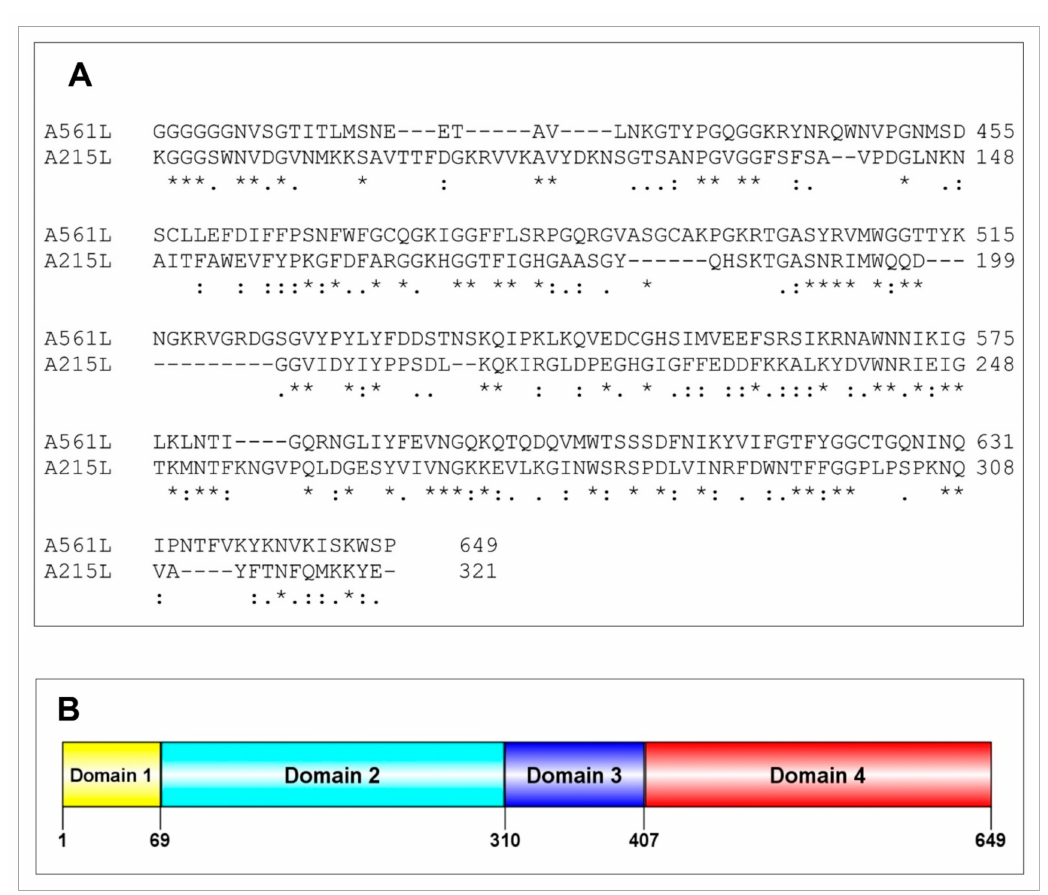
Figure 1. A561L protein characteristics: domains and possible functions: ( A ) Amino acid sequence pairwise alignment of a carboxyl-terminal domain of CDS A561L with the carboxyl terminus of CDS A215L; A215L was previously characterized as a polysaccharide lyase [vAL-1 protein] [38]. ( B ) Predicted domains in A561L—domain 4 is the part of the protein that resembles A215L (domains were identified using InterPro domain prediction database [39] with manual curation). Domain 1 has a transmembrane domain and the closest match is a transporter protein encoded by Listeria kieliensis although the E-value was low, 3.6 × 10 − 1 ; Domain 2 has the best hit to a TolA protein of Trichomonas vaginalis (Tol proteins are involved in the stability of the outer membrane in Gram-negative bacteria) with an E-value of 4.1 × 10 − 14 but it also resembles a peptidase S8 domain-containing protein from Tetradesmus obliquus with an E-value of 9.3 × 10 − 8 ; Domain 3 resembles a LEA 2 domain-containing protein (late embryogenesis abundant protein, which plays a role in abiotic stress response and tolerance in plants and are part of the hypersensitive response to plant pathogen infection) encoded by Selaginella moellendorffii with an E-value of 6.9 × 10 − 6 ; and Domain 4 resembles an alkaline alginate lyase/1–4 polyglucuronic acid lyase/polysaccharide lyase family 14 with an E-value of 2.1 × 10 − 14